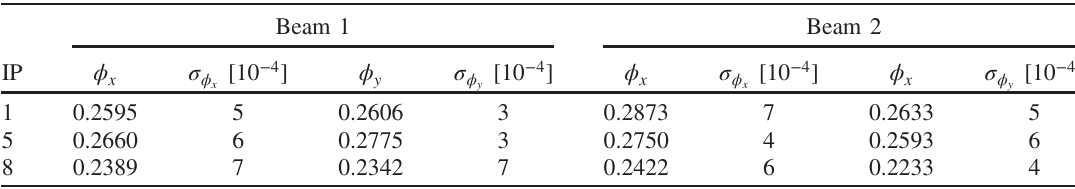
TABLE V. Measured phase advance and standard deviation (in 2 π units) in IR1, IR5, and IR8 during the 2016 MD on vdM optics.